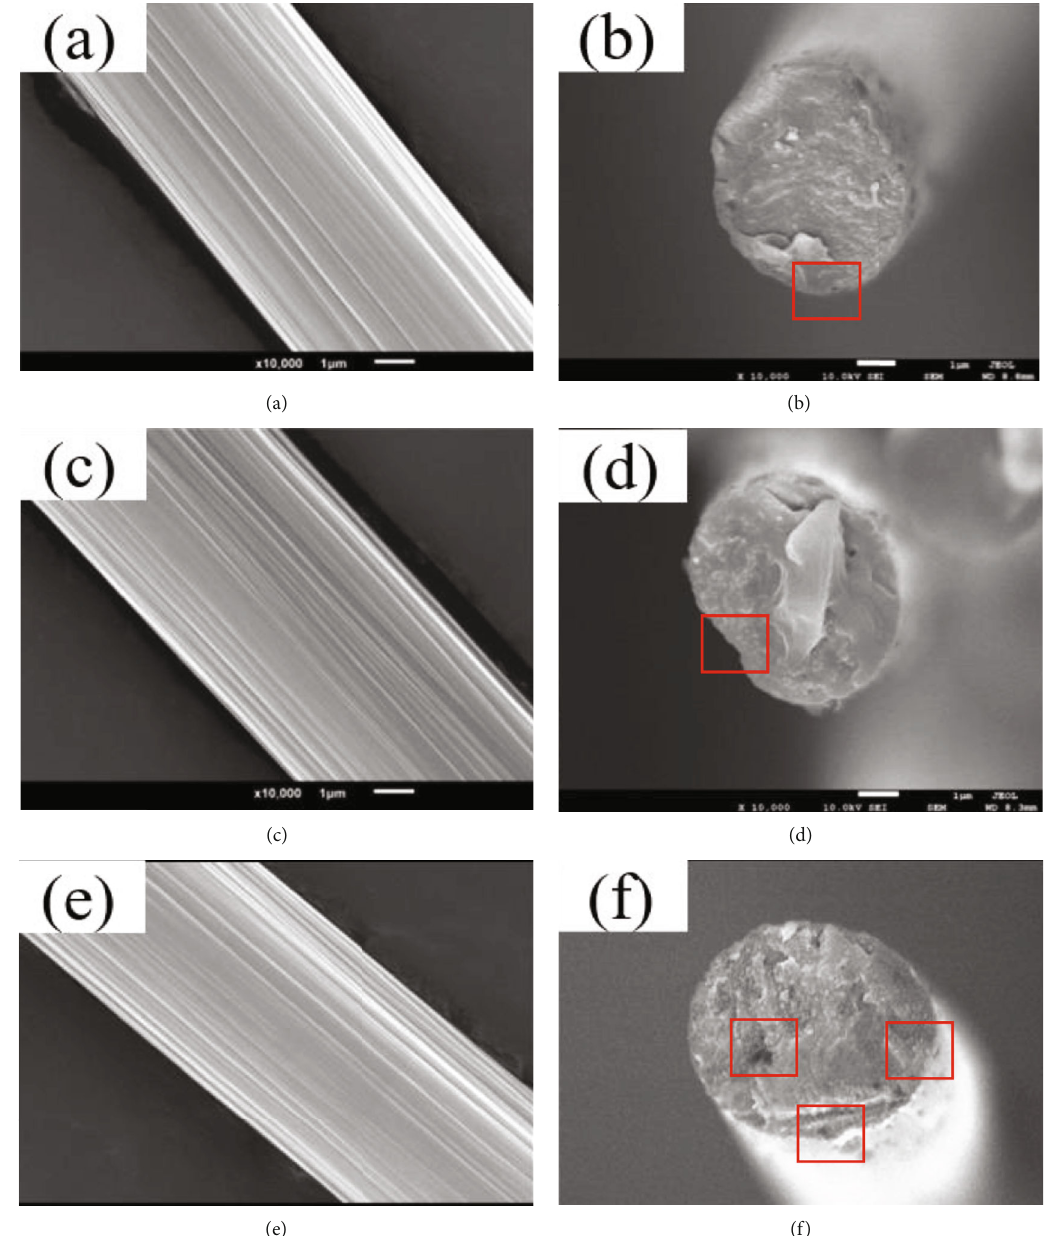
Figure 1: The morphology of surface and fracture section: (a, b) CCF800A; (c, d) CCF800B; (e, f)